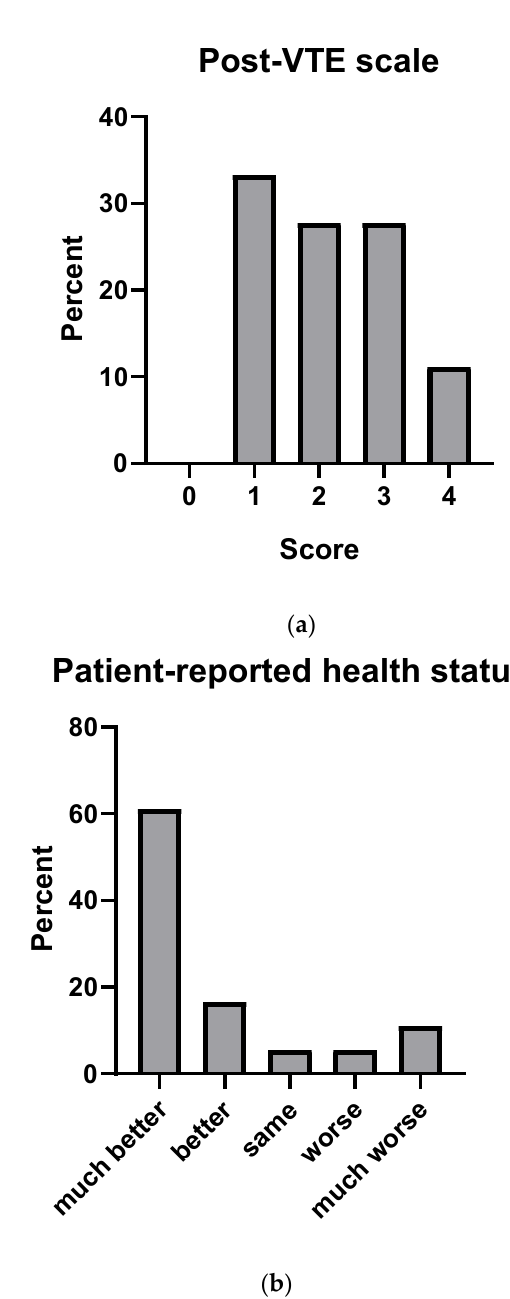
Figure 3. ( a ) Post ‐ VTE (venous thromboembolism) functional status scale and patient ‐ reported health status at long ‐ term follow up. 0, No significant functional limitations; 2, Slight functional limitations; 3, Moderate functional limitations; 4, Severe functional limitations. ( b ) 78% reported much better or better health status compared to before admission to pulmonary rehabilitation.